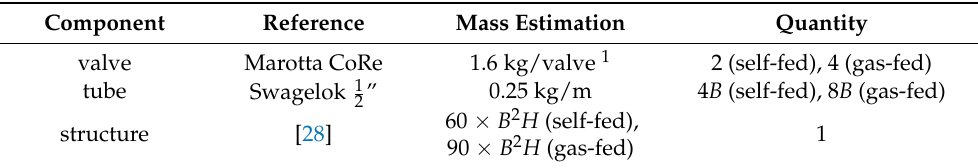
Figure 8. Simplified schematic of self-fed N 2 O supply, and gas-fed oxidizer supply systems. Table 3. Summary of oxidizer supply component mass